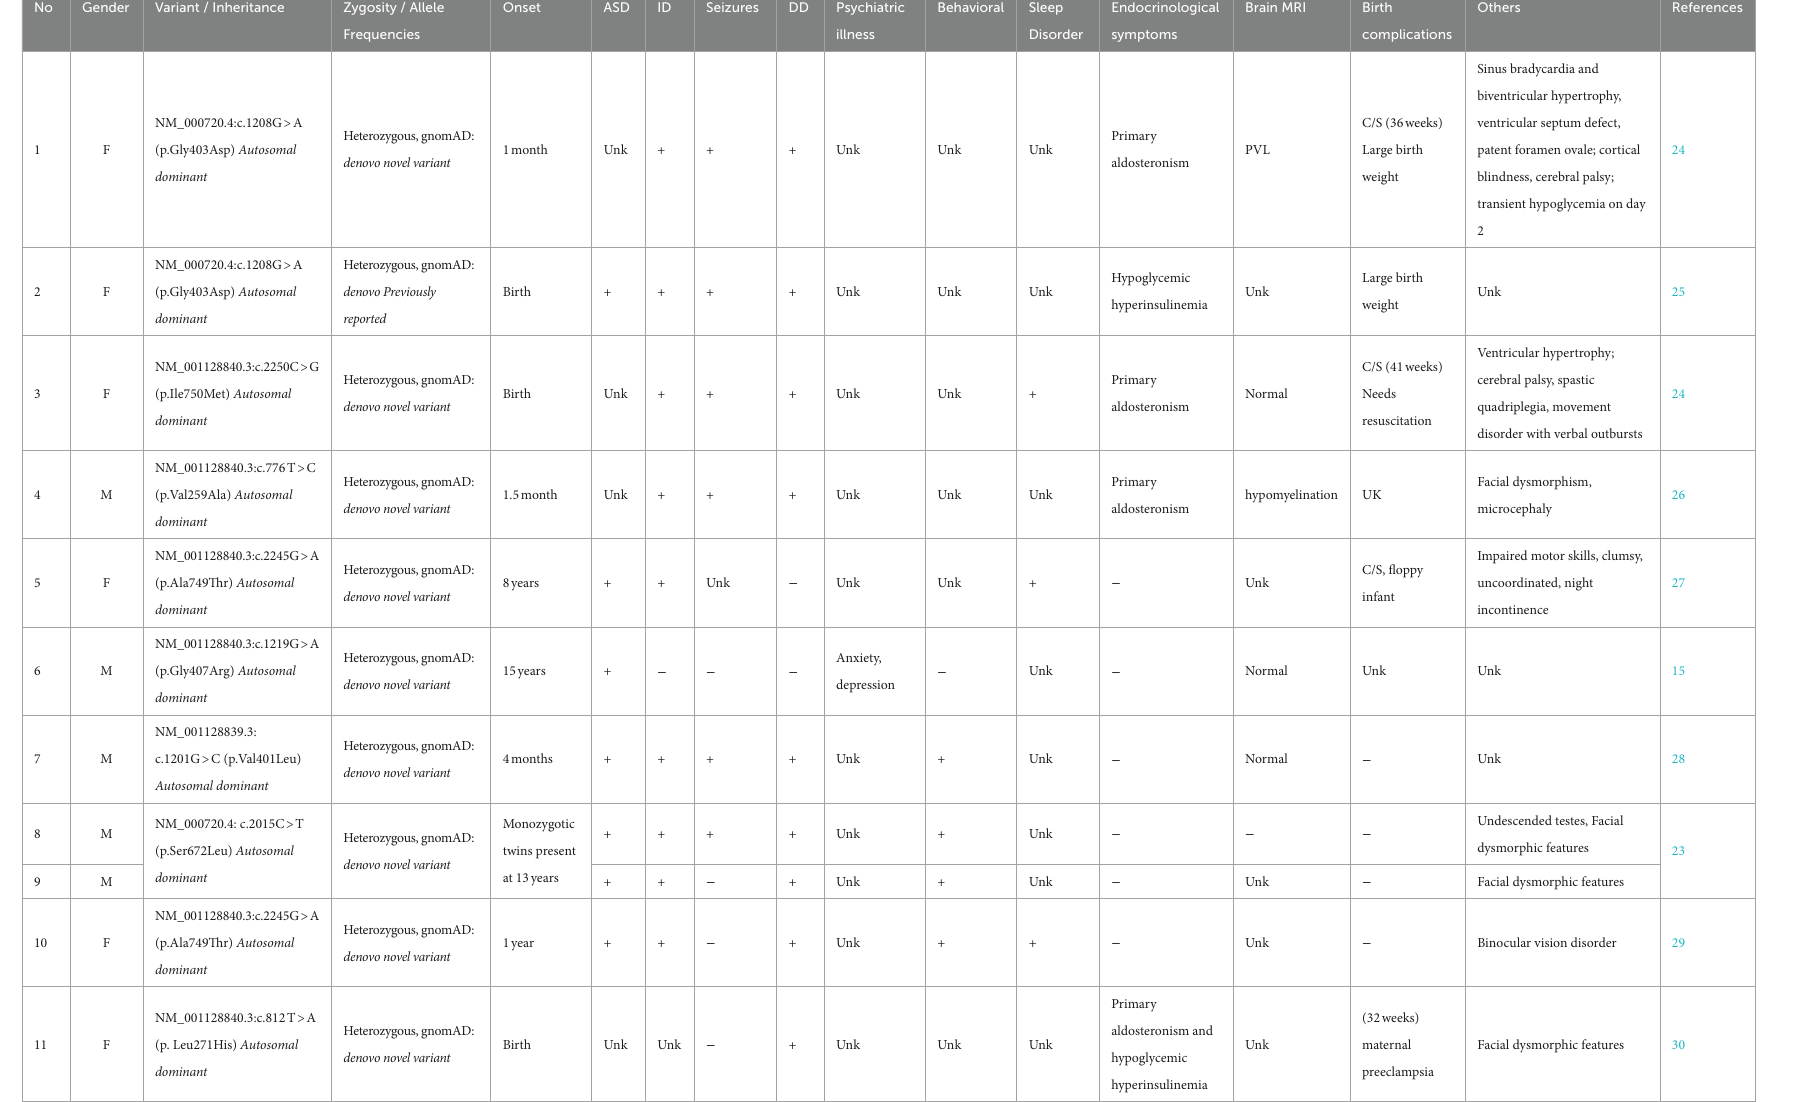
TABLE 2 Clinical phenotypes of reported cases with heterozygous missense gain of function mutation of CACNA1D . No